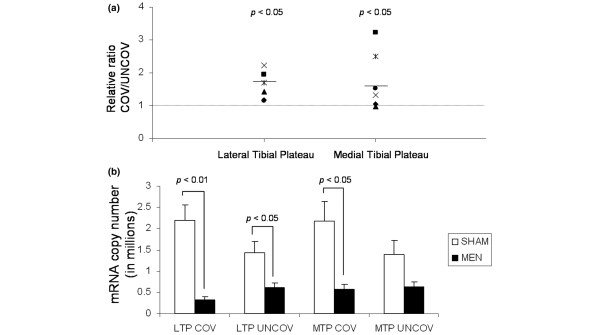
Quantitative real-time PCR. (a) Topographical variation in proteoglycan 4 (PRG4) expression in sham-operated ('normal') joints as demonstrated by the ratio of mRNA copy numbers from cartilage normally covered (COV) versus cartilage normally uncovered (UNCOV) by menisci; in each case the average value is indicated by the line (n = 6). The dotted horizontal line represents the expected ratio of 1 if there were no difference between regions. (b) PRG4 mRNA copy numbers (means ± SEM) from ovine articular cartilage after lateral meniscectomy (MEN). LTP, lateral tibial plateau; MTP, medial tibial plateau.